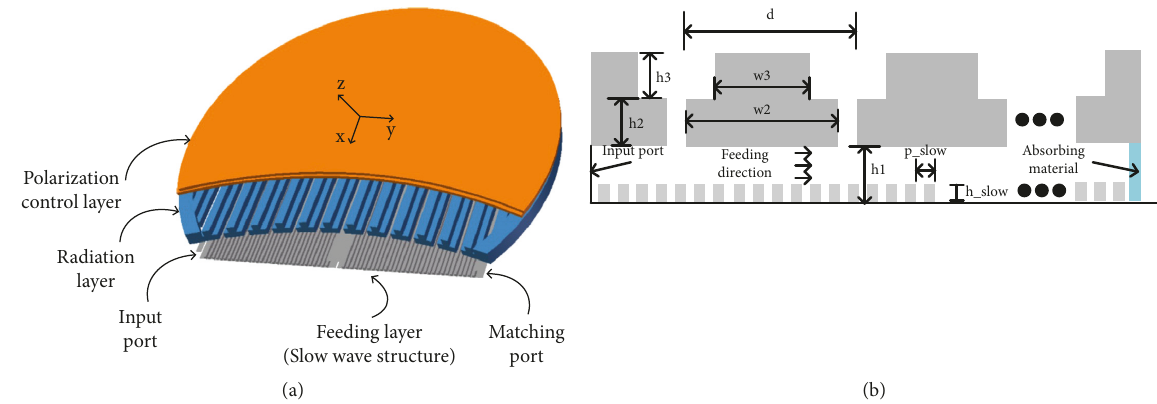
Figure 1: Diagrams of variable inclination continuous transverse stub (VICTS) antenna: (a) three-dimensional perspective and (b) side